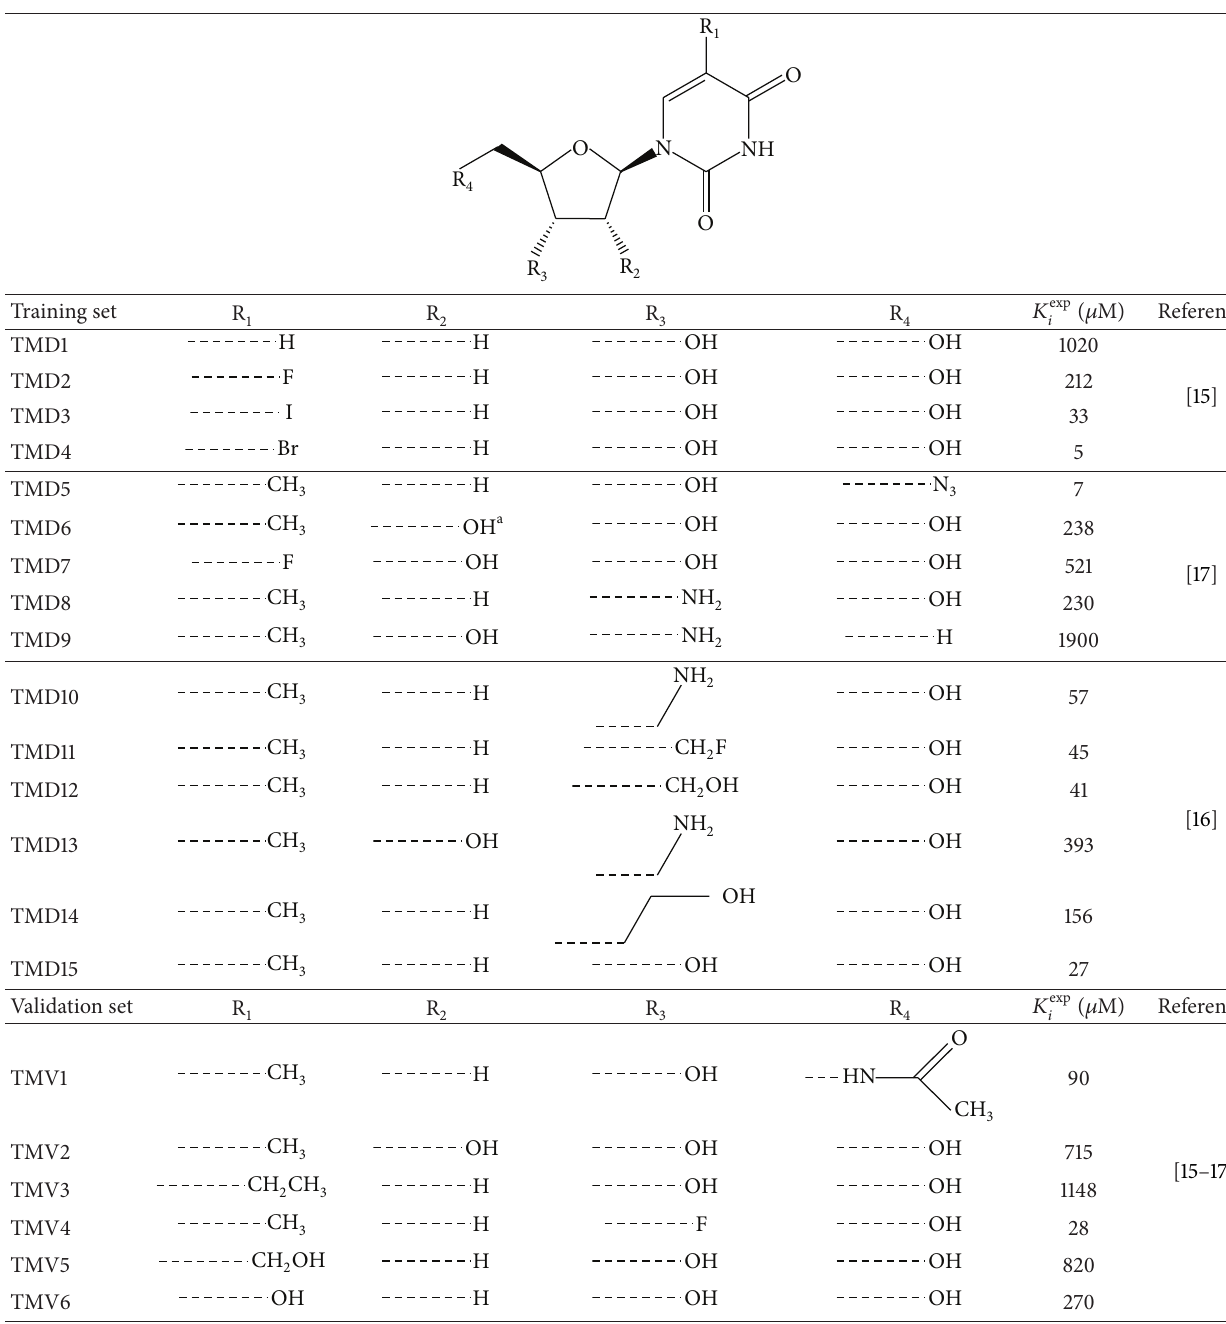
Table 1: Training and validation sets of TMD inhibitors for QSAR